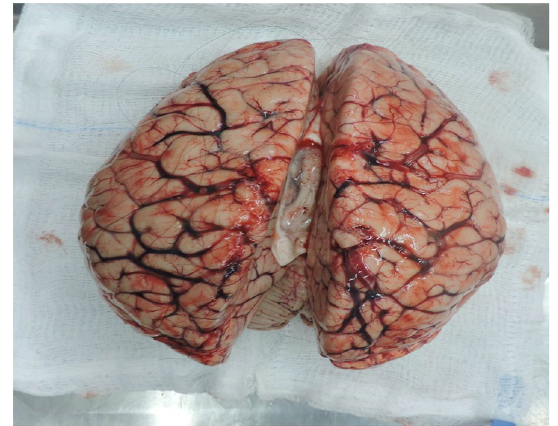
Fig. 9 Significant brain swelling with gyral flattening, sulcal narrowing and congestion